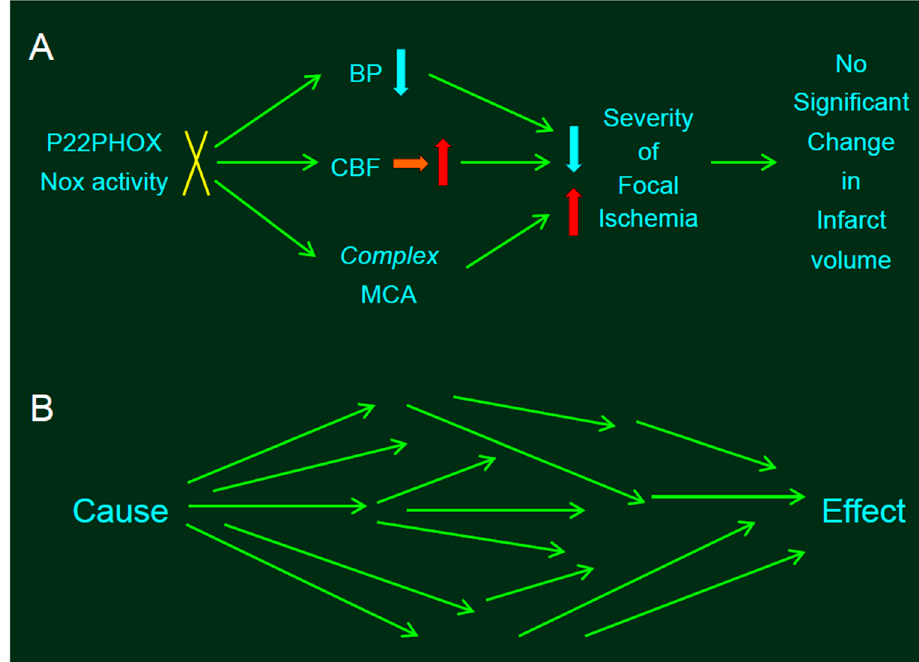
Figure 2. Statistical problems in experiments involving genetic manipulation. ( A ) The absence of p22 phox protein did not affect infarct size produced by distal middle cerebral artery occlusion (MCAO). Resting mean blood pressure (MABP) in SP.MES rats was decreased slightly but significantly relative to that observed in control PM0/SHRSP rats, along with mitigated CBF. Thus, slightly but significantly decreased resting blood pressure (BP)—along with mitigated CBF—would decrease the infarct size in SP.MES, whereas more complex MCA might have resulted in larger infarction. The blue, red, and orange arrows indicate decrease, increase, and no significant change, respectively. ( B ) Such divergent effects of genetic manipulation provoke a critical problem. If the experiments were adequately randomized, we can conclude that the effect—significantly different between the groups—was due to a single cause, because the background factors between the groups were same; in other words, no factor except for a single cause can be the reason for the difference between the groups (i.e., the single effect) after randomization. However, when a single cause (e.g., knockout of a gene) induced multiple influences converging into a single effect (e.g., infarct volume), this assumption is invalid.